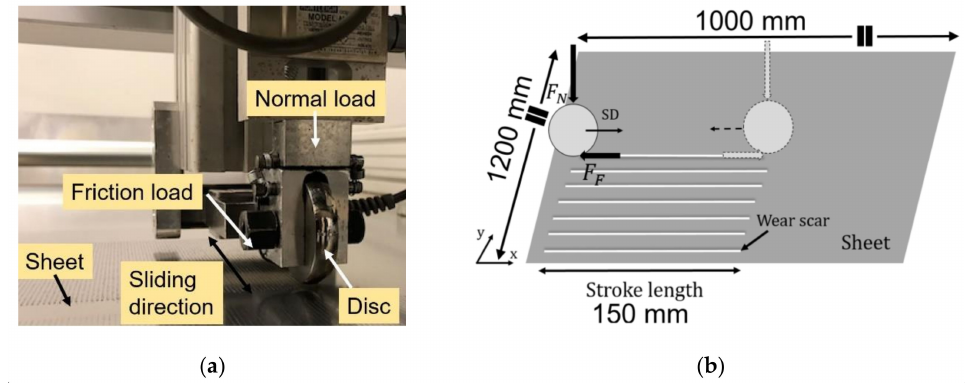
Figure 2. ( a ) Slider-on-flat-surface (SOFS) tribotester and ( b ) schematic of the performed tests by SOFS. F N stands for a normal load, F F stands for friction force and SD indicates sliding